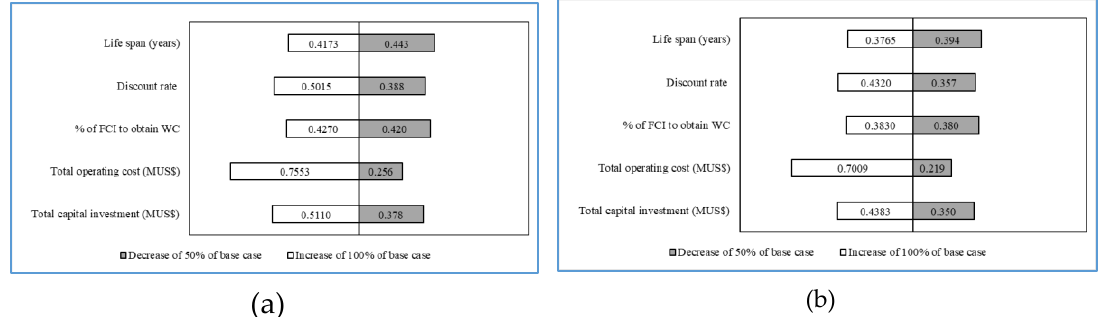
Figure 4. Sensitivity assessment for unit processing cost of waste plastic (USD / kg) in scenario i ( a ) and scenario ii ( b ).